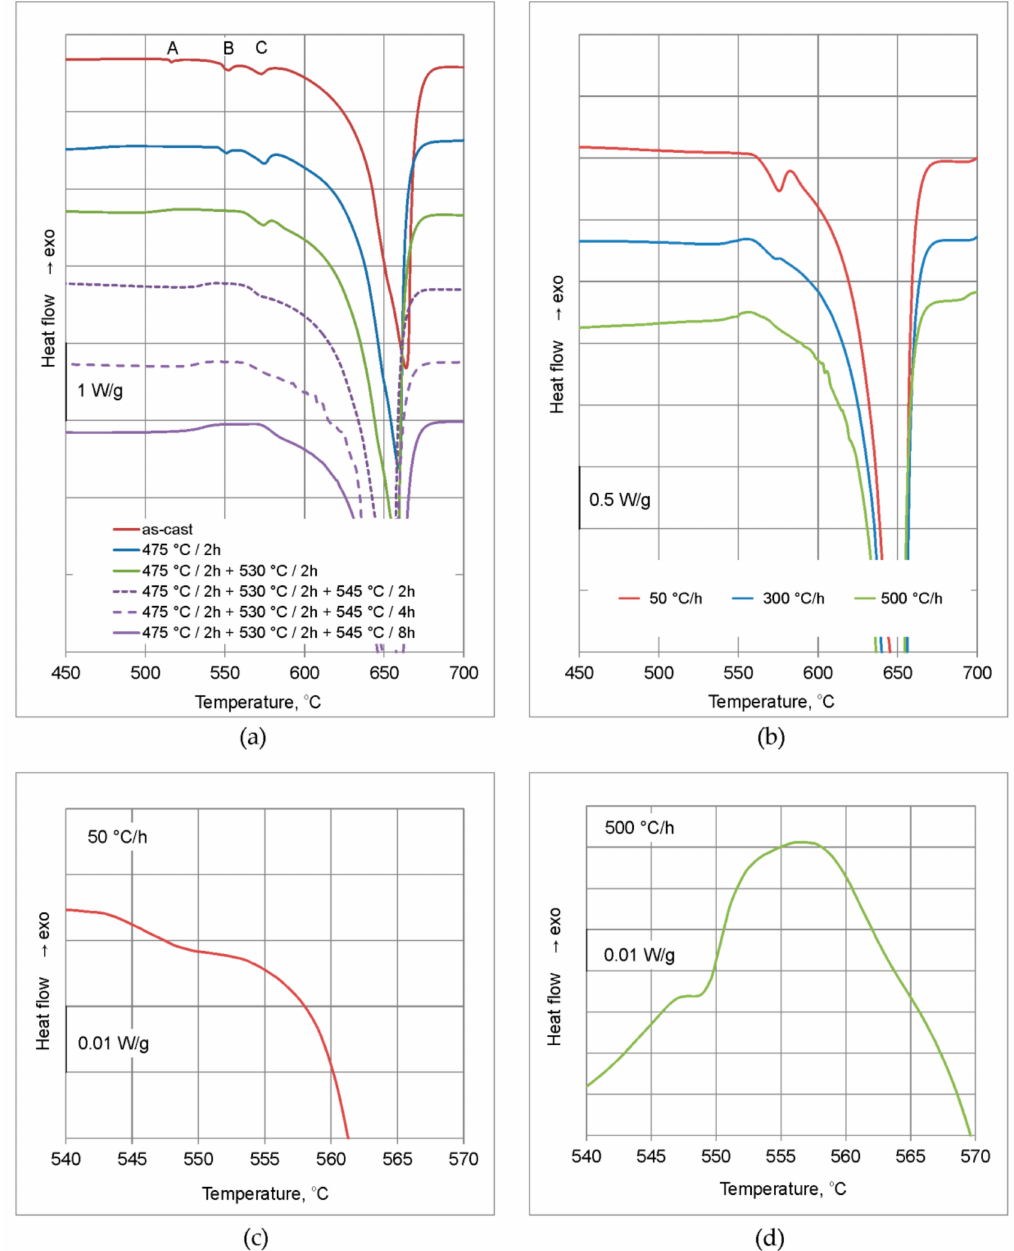
Figure 2. DSC curves: ( a ) As-cast state and after homogenization with differentiated soaking and water quenching; ( b ) after homogenization with soaking 475 ◦ C/2 h + 530 ◦ C/2 h + 545 ◦ C/8 h and differentiated cooling rate; ( c , d ) magnified parts of curves from panel b showing very small peaks at about 545 ◦